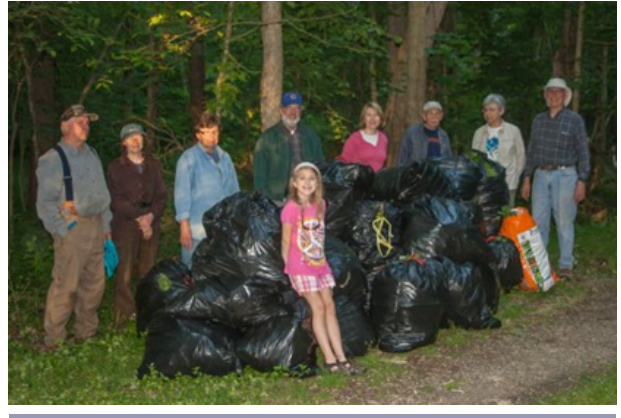
Fig. 5. The Garlic Mustard Challenge supports cross- generation